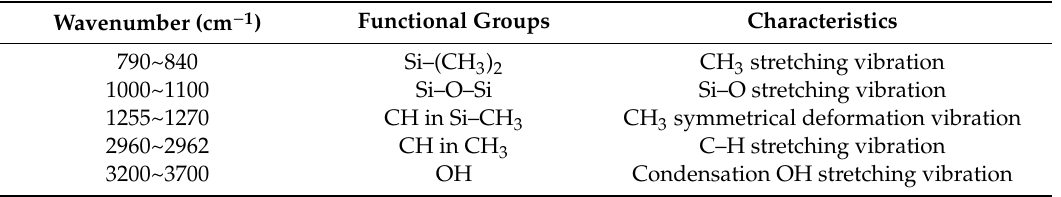
Table 7. FTIR absorption bands of silicone